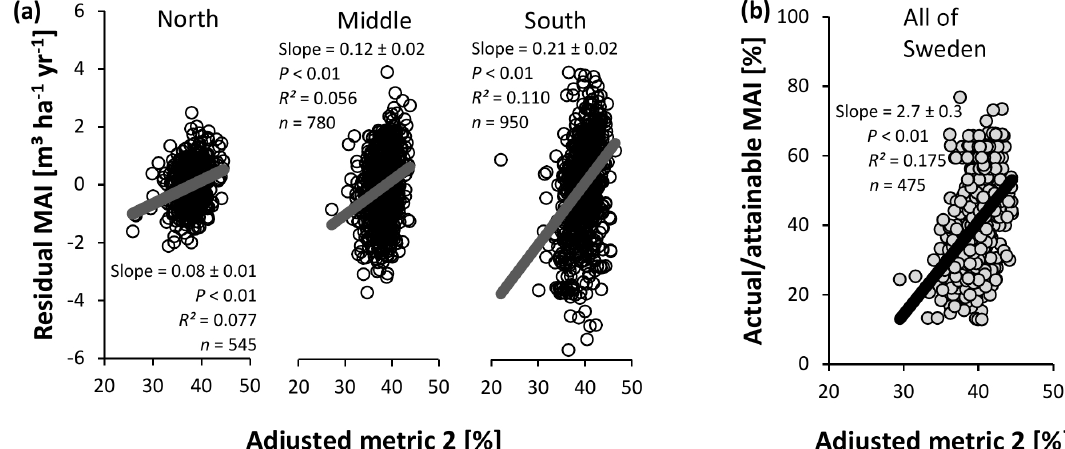
Figure 11. Evaluation of adjusted nutrient availability metric 2 for Swedish conifer forests. (a) Method 1 – association with residual mean annual increments (MAIs) of the productivity–climate regression model (Fig. 3a, Eq. S1 and Table S2), distinguishing northern, middle, and southern Sweden. (b) Method 2 – association with actual / attainable MAI (Fig. 3b) for the entire Swedish land area. Full line: significant slope ( P